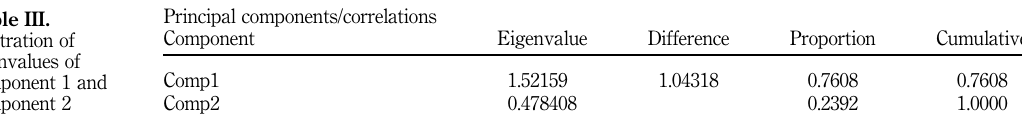
Table II. Pairwise correlation between market capitalization and number of equities ratios